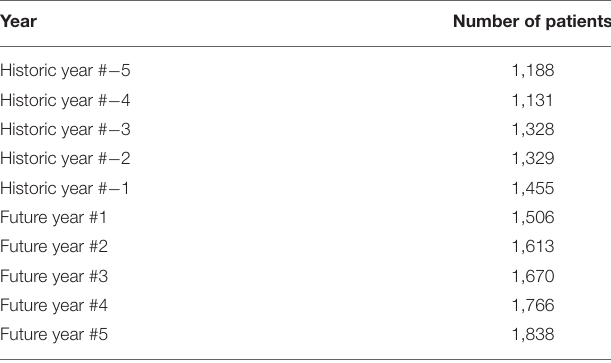
TABLE 1 | Total number of AIS patients modeled in the study over the 5-year